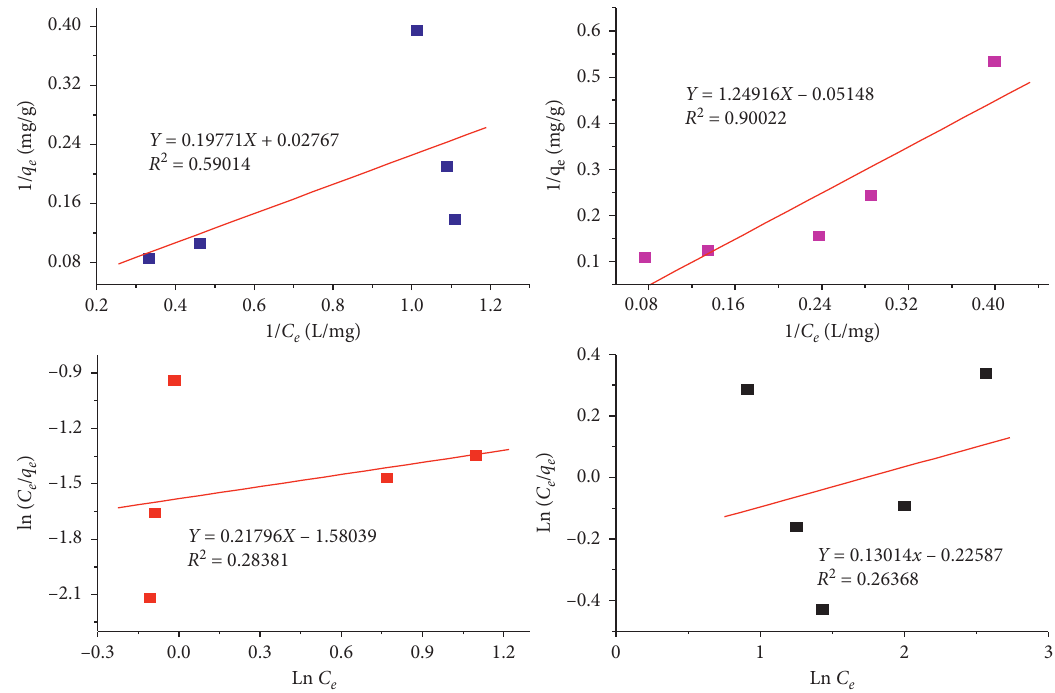
Figure 13: Sips isotherm (a) for ALAPW and (b) for RLAPW, Redlich–Peterson isotherm (c) for ALAPW and (d) RLAPW.